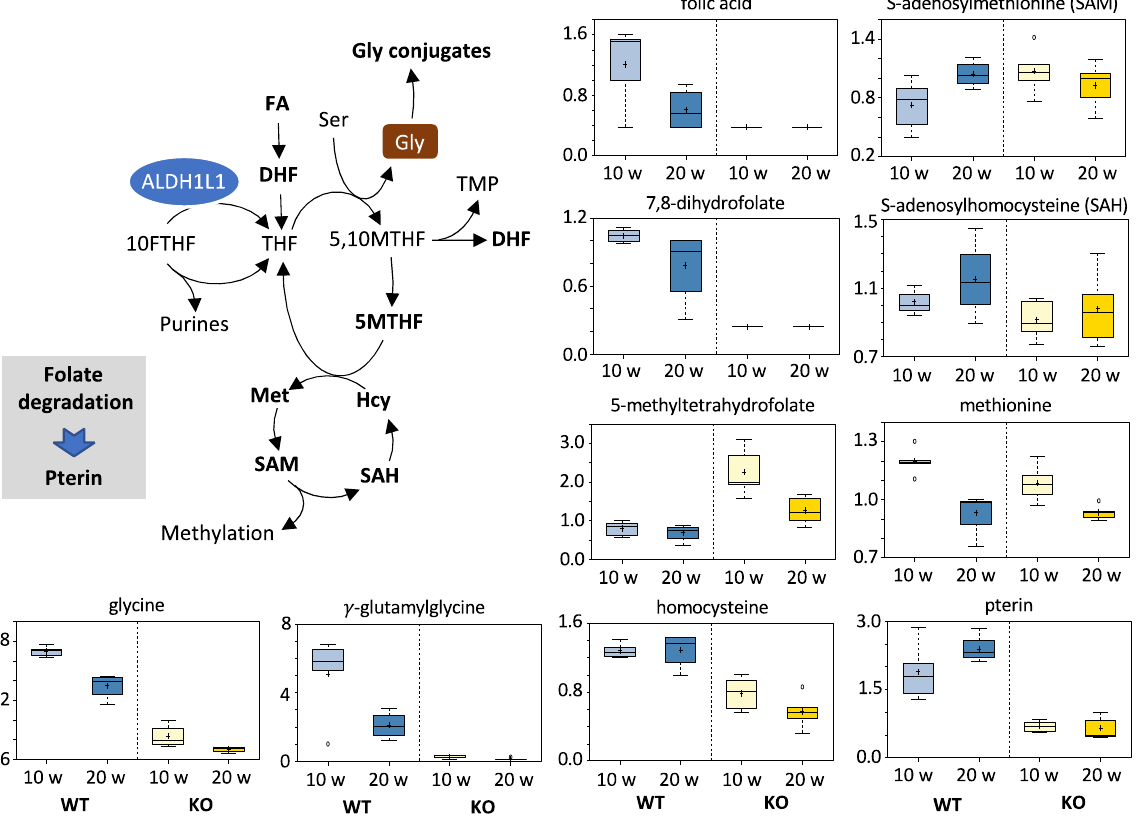
Figure 5. Comparison of the folate pathway metabolites between animal groups. Schematic depicts folate metabolism as it is relevant to listed compounds. Folate degradation is proposed as the source of pterin. Y -axes of individual metabolite box plots represent scaled intensity. Measurements for each biochemical in the original scale were rescaled to set the median equal to 1. Abbreviations: FA, folic acid; DHF, 7,8-dihydrofolate; THF, tetrahydrofolate; 5MTHF, 5-methyltetrahydrofolate; 5,10MTHF, 5,10-methylene-THF; 10FTHF, 10-formyl-THF.